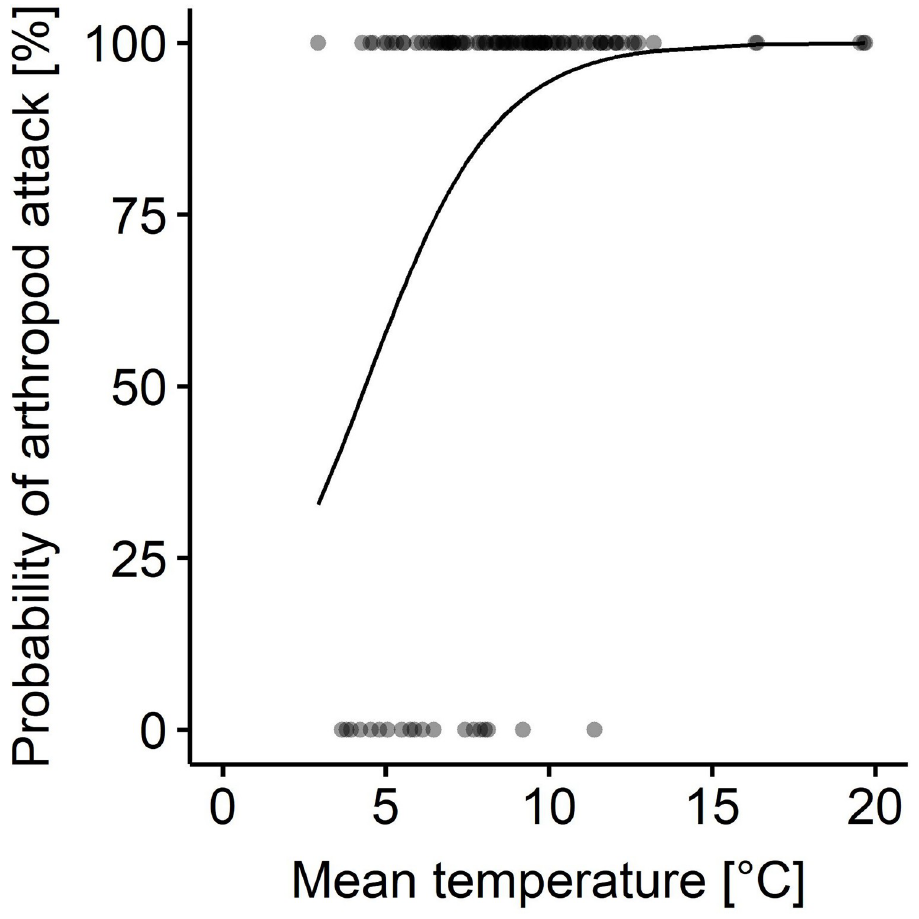
Fig 1. Probability of arthropod attack relative to local mean temperature during artificial caterpillar exposure. Logistic regression curve and dots indicate absence (0) and presence (1) of arthropod attack on artificial caterpillars at plot